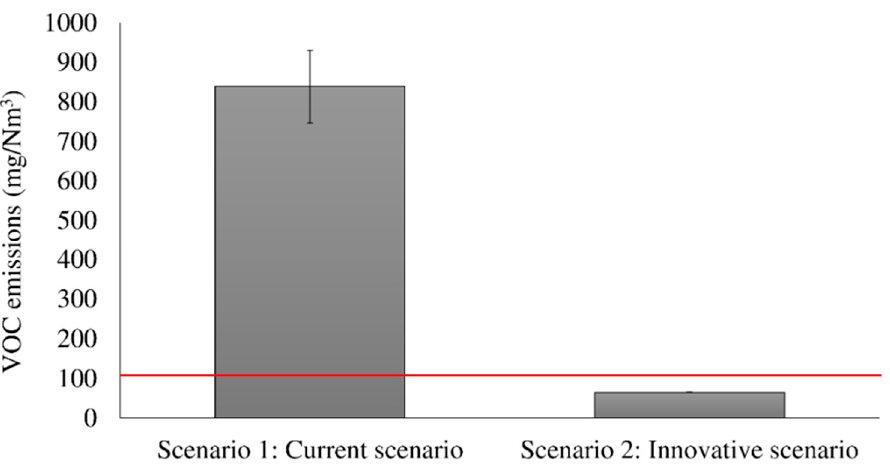
Figure 2. Emissions from door production chain: current vs. UV abatement systems. Red line represents the Italian legal limit for volatile organic compound (VOC) emissions.